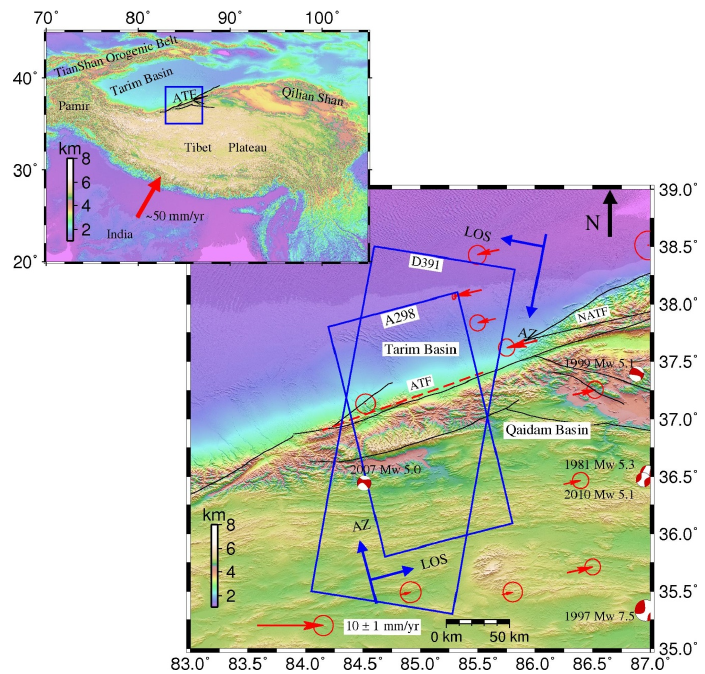
Figure 1. Location and velocity map of the Altyn Tagh Fault (ATF). The top left figure shows the whole tectonic background of the ATF, the low right figure is the zoom-in of the blue rectangular in it and shows the velocity map. In the low right part, the black solid line indicates the ATF. The blue rectangle is the InSAR frame of D391 and A298. The red dashed line is the estimated fault location, and the blue arrows represent the azimuth and LOS direction. The focal mechanism symbols represent the events after 1976 from the Harvard CMT catalogue. The black arrow shows the north direction. The red arrows with ellipses show the GPS velocity projected to the rough fault line. The GPS velocity is from Ge et al. [11].